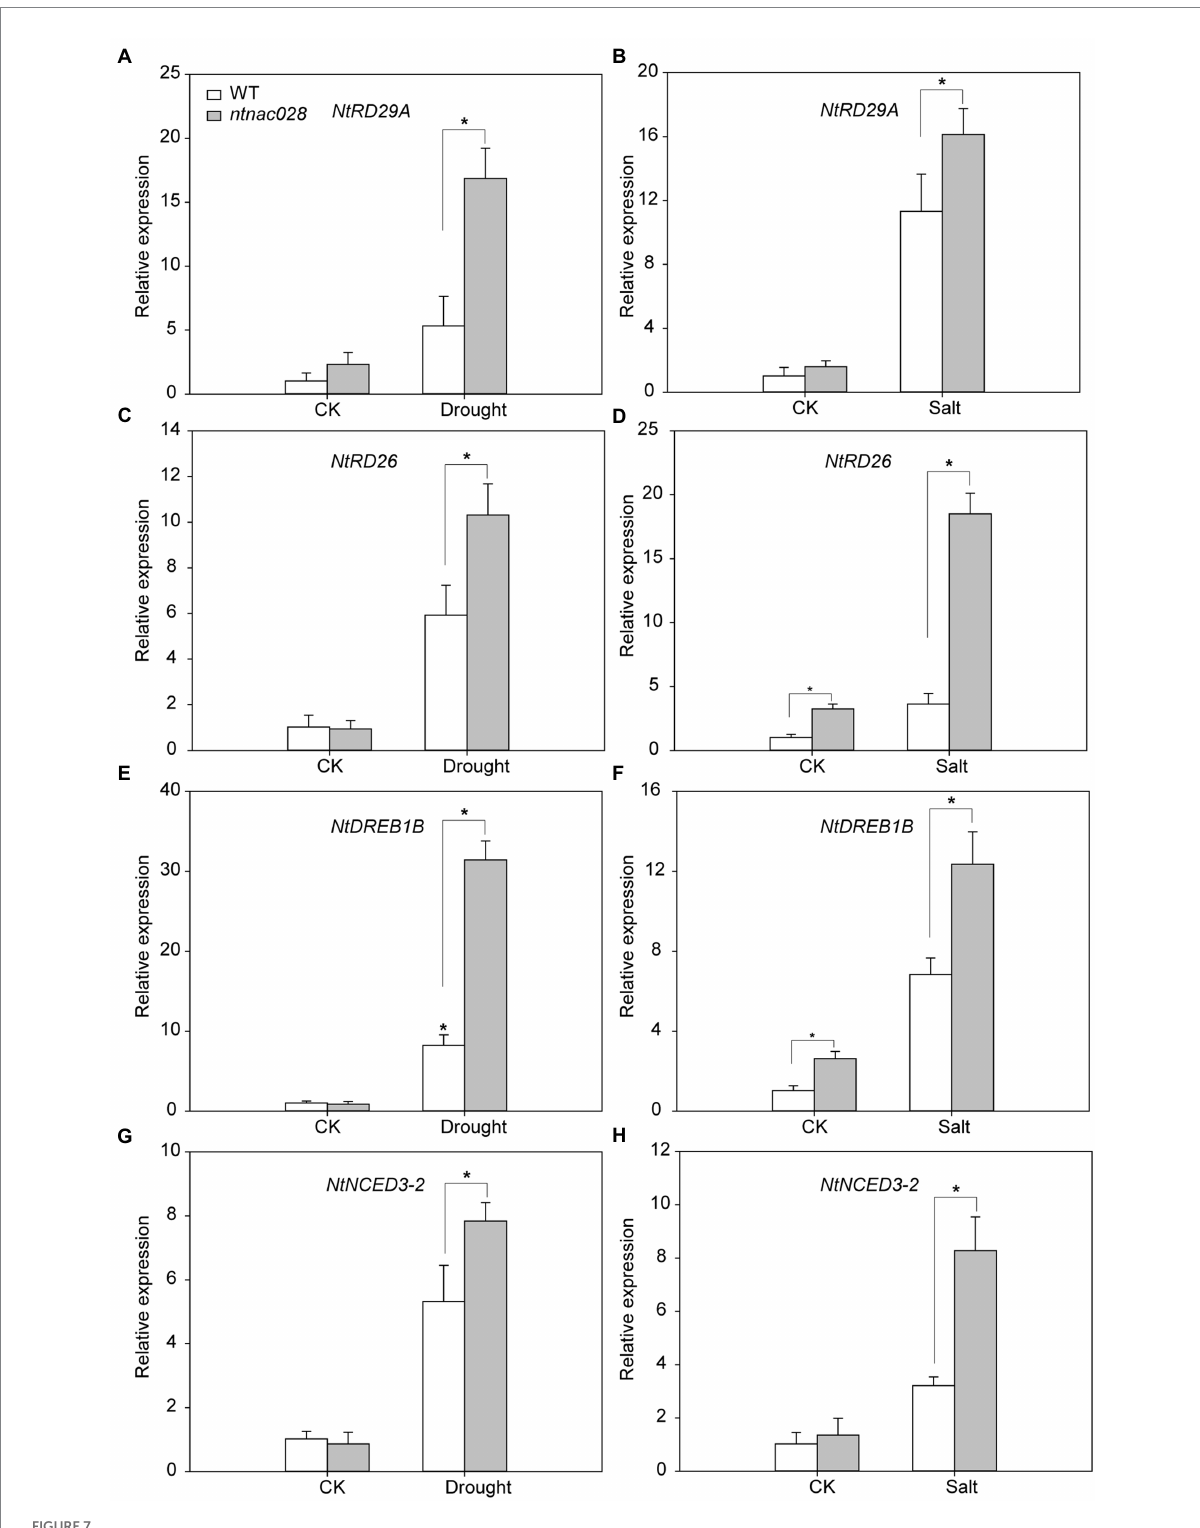
FIGURE 7 Expression patterns of stress-responsive genes in WT and ntnac028 plants under salt and drought treatments. Relative transcript levels of four stress-responsive genes (RD29A, RD26, DREB1B, and NCED3-2) in WT and ntnac028 plants before and after drought (A,C,E,G) and salt (B,D,F,H) treatments. The bars are standard deviations (SD) of three biological replicates. Asterisks indicate statistically significant difference from WT (* p <